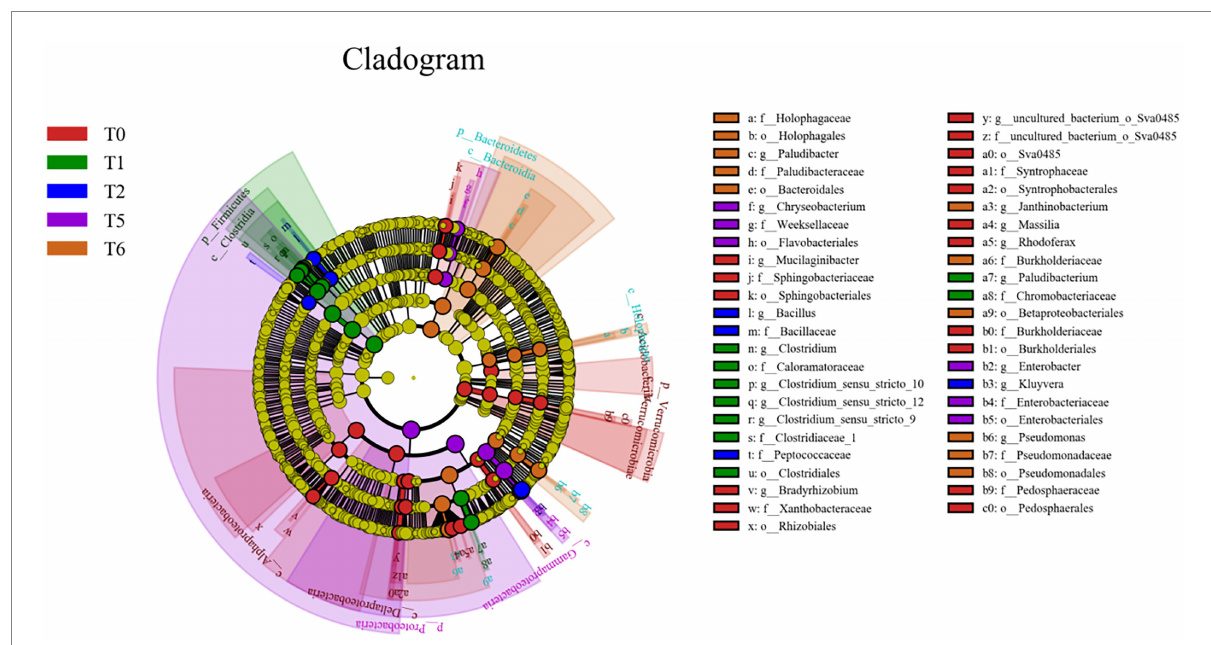
FIGURE 5 The LEfSe results of the differences between the initial system (T0) and S (T1), SG (T2), AS (T5) and ASG (T6) microbial community.